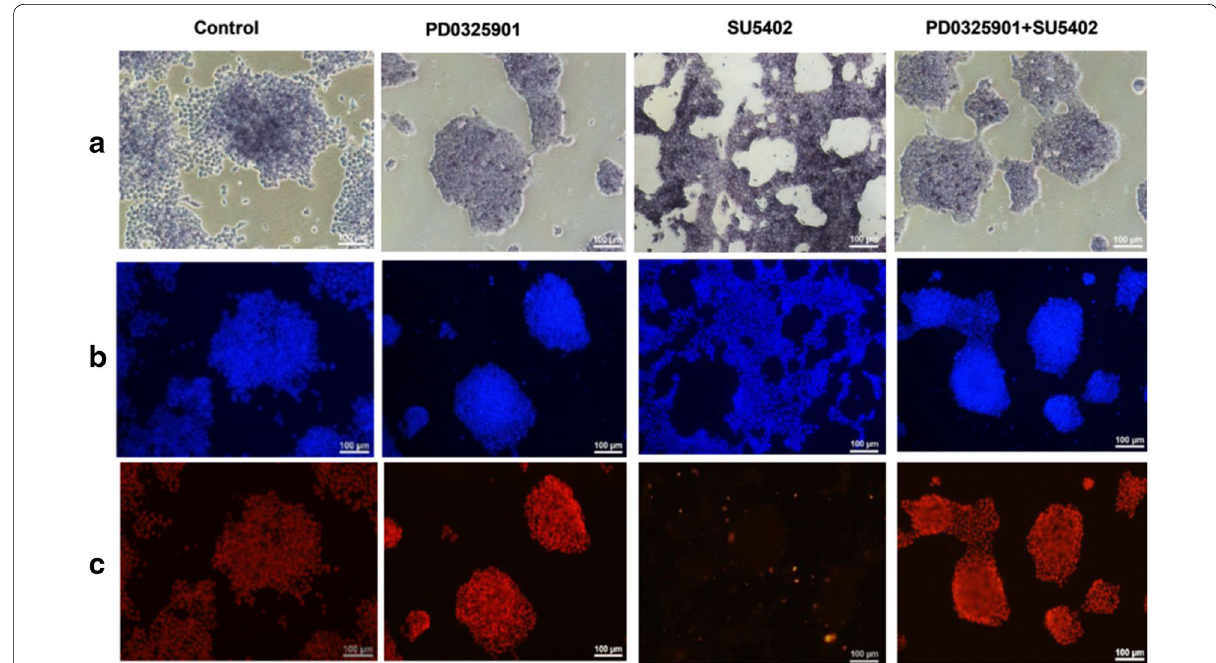
Fig. 3 Cells were cultured with 1 uM PD0325901, 2 uM SU5402 or their combination. a Alkaline phosphatase staining. b DAPI staining for nuclei. c Immunofluorescence staining for OCT4 ( c ). Scale bar: 100